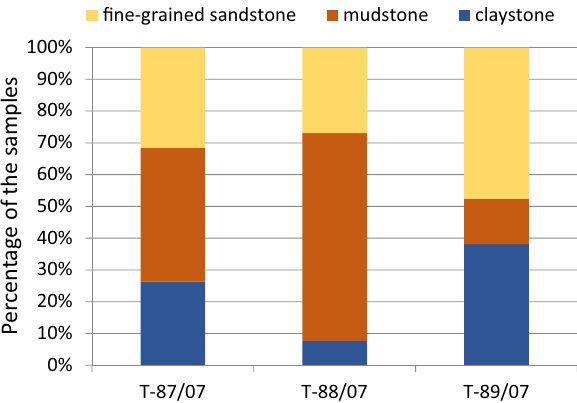
Fig. 4 Different rock types used in the laboratory compressive strength